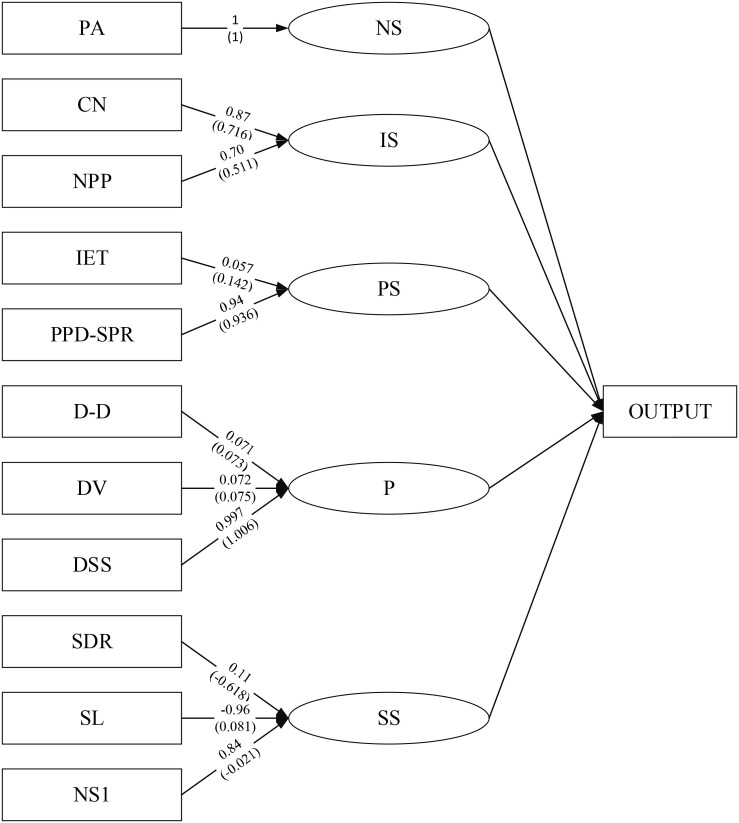
Measurement model.